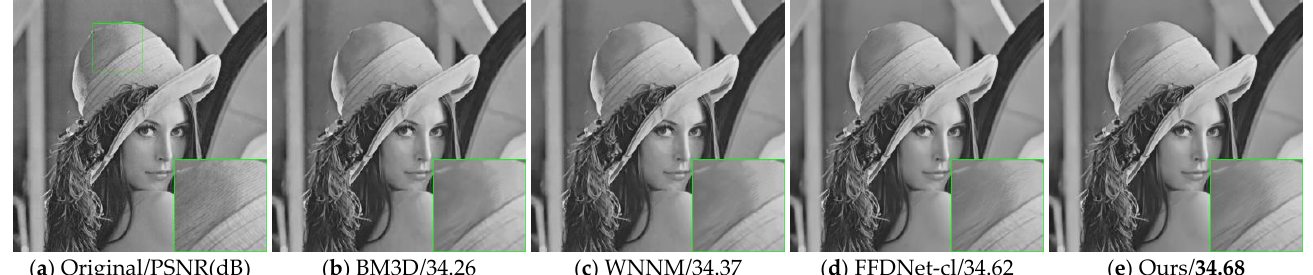
Figure 4. Image denoising results on Lena with noise level σ n = 15. ( a ) The original image. ( b ) The result of BM3D. ( c ) The result of WNNM. ( d ) The result of FFDNet-cl. ( e ) Our result.